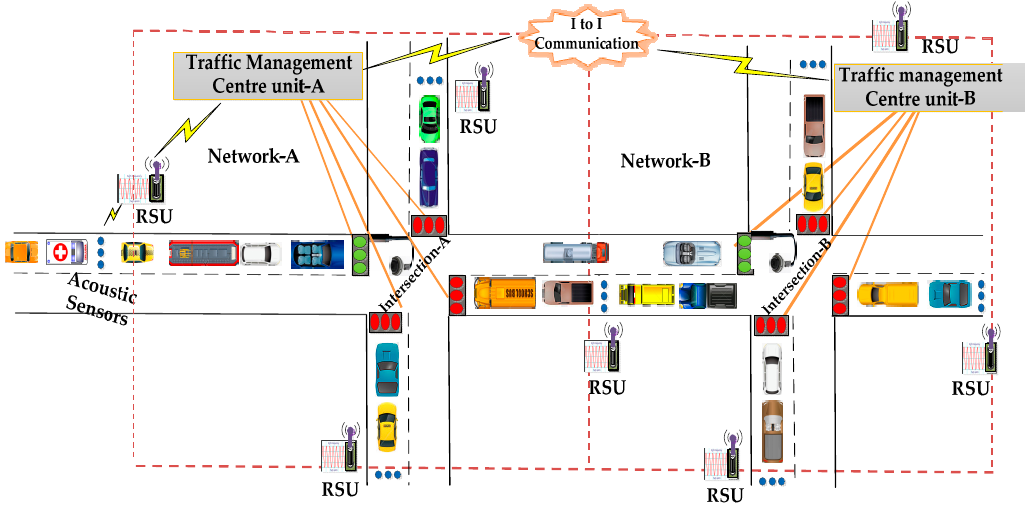
Figure 2. Architecture of an urban traffic management system.